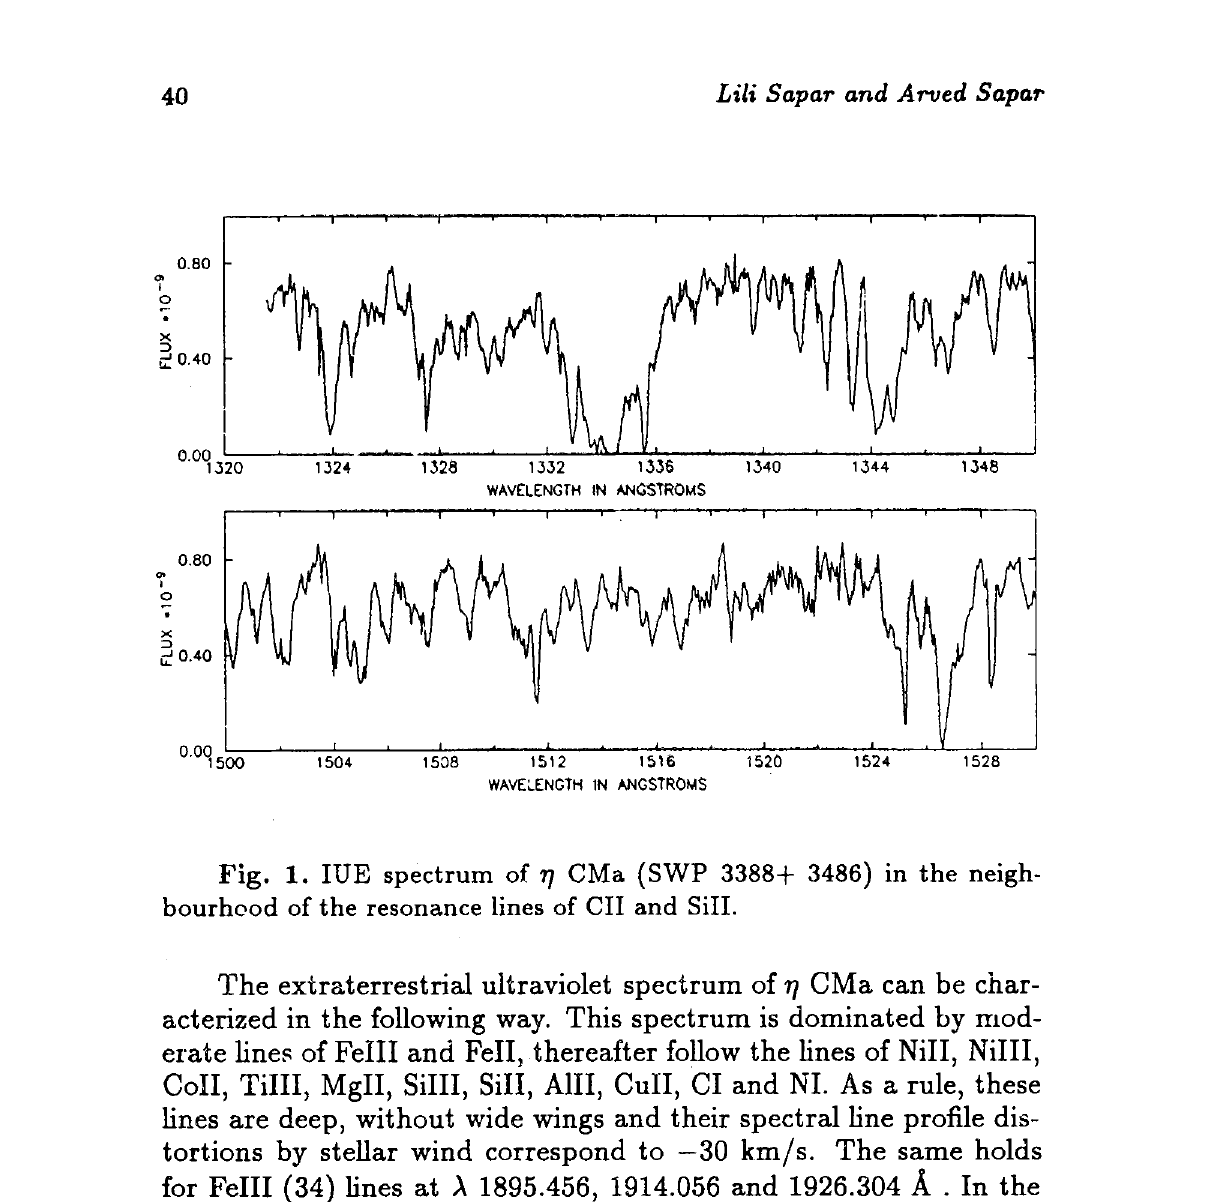
Fig. 1. IUE spectrum of r) CMa (SWP 3388+ 3486) in the neigh- bourhood of the resonance lines of CII and